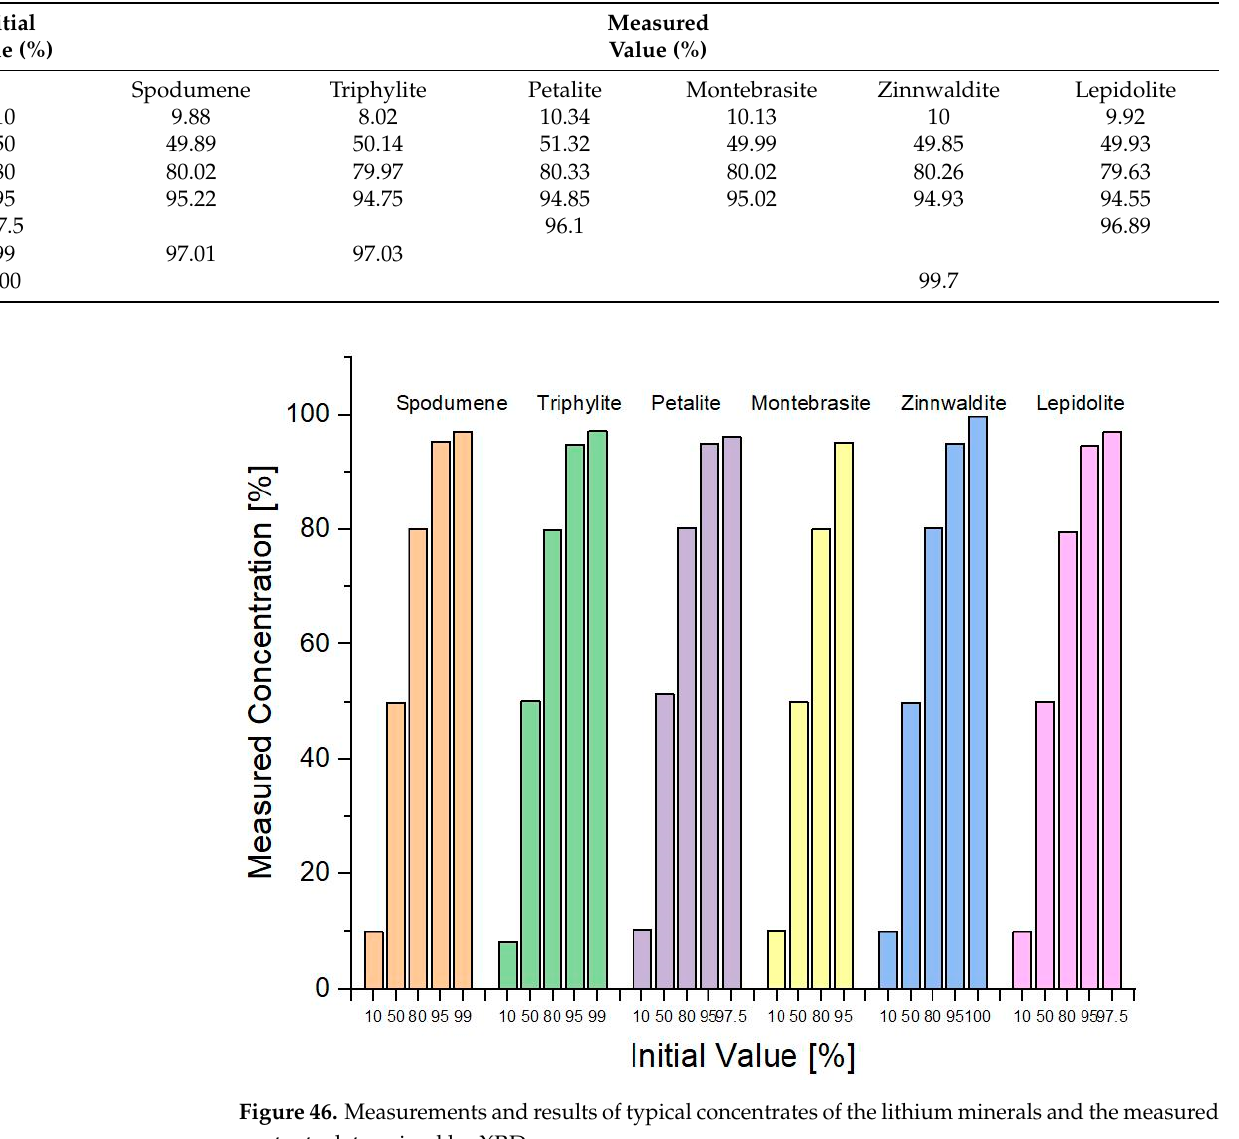
Table 6. Examples of PLSR results of lithium ores based on definite initial values given and their measured results from XRD.